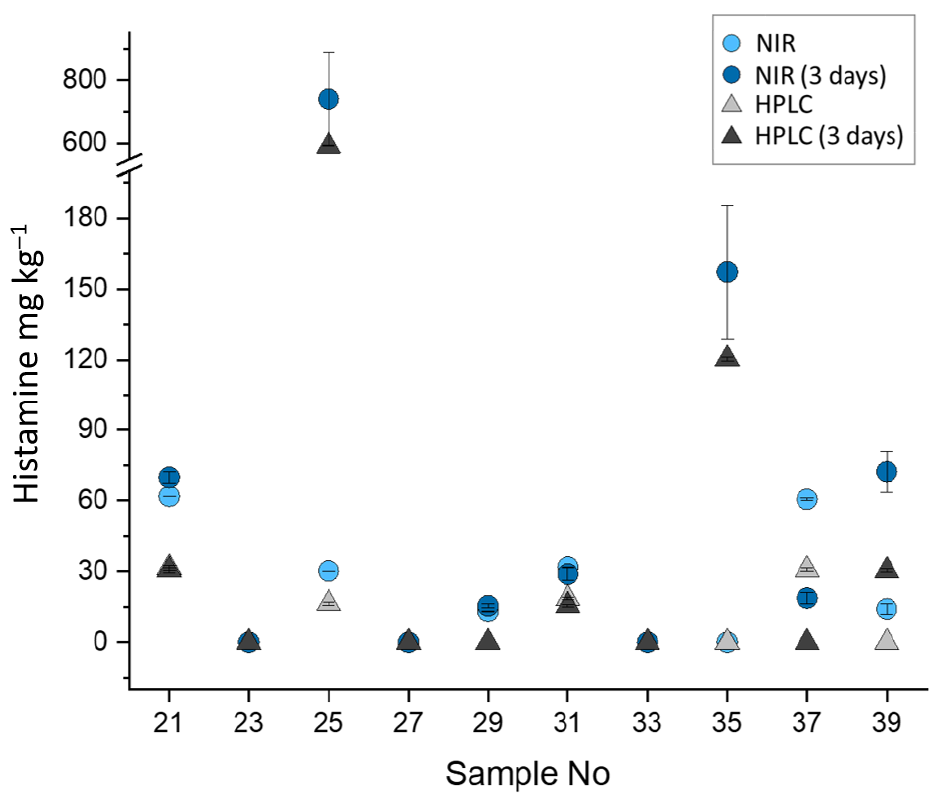
Figure 4. Histamine quantification results in raw tuna fish by NIR and HPLC before and after storage at 20 ± 1 °C for 3 days.